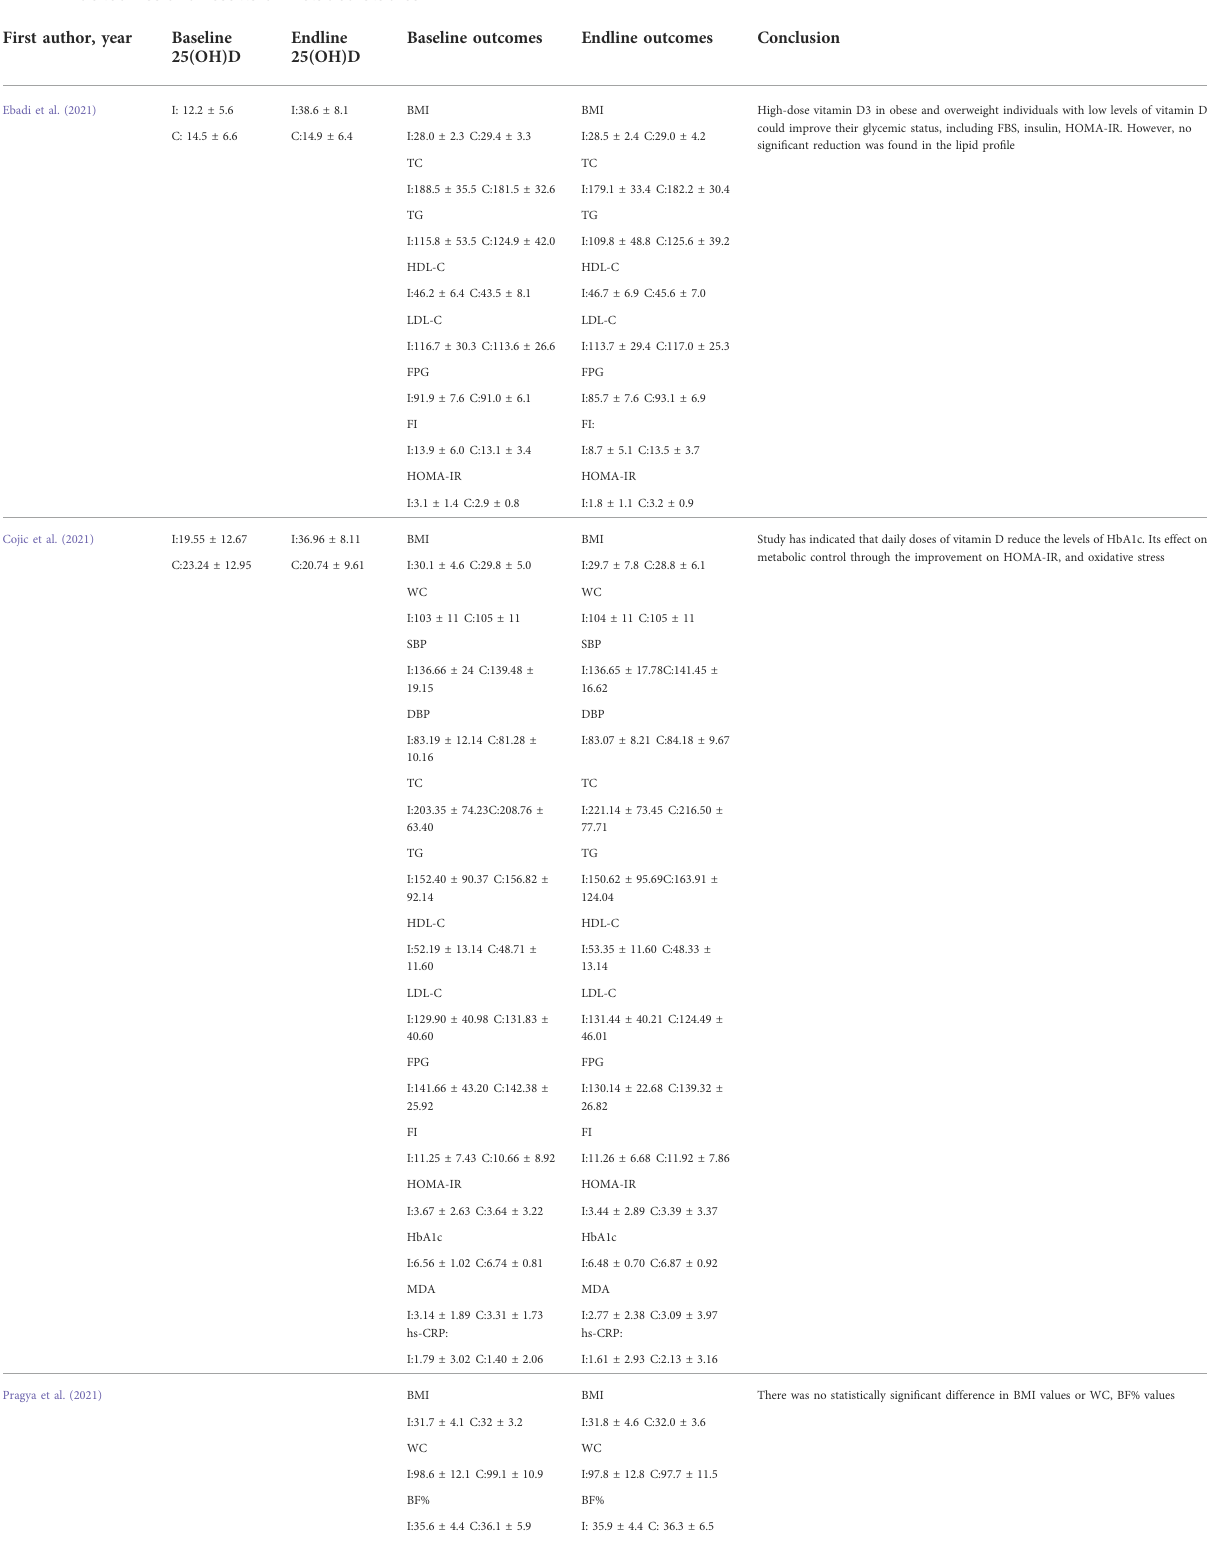
TABLE 2 Outcomes and results of included